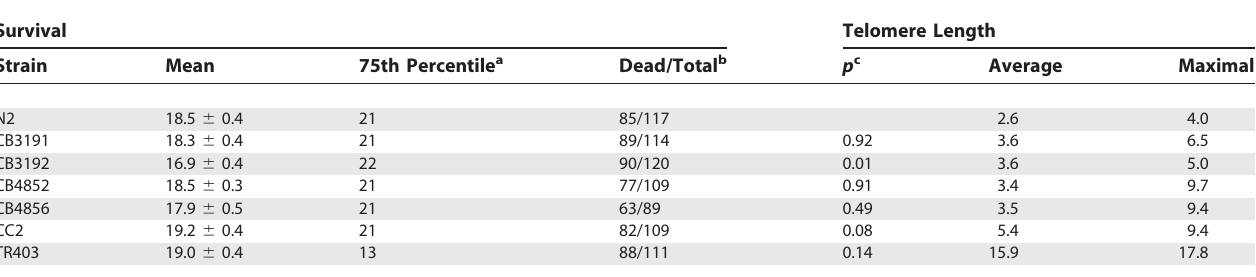
Table 1. Survival, Average and Maximal Telomere Length of Different Worm Strains Survival Telomere Length Strain